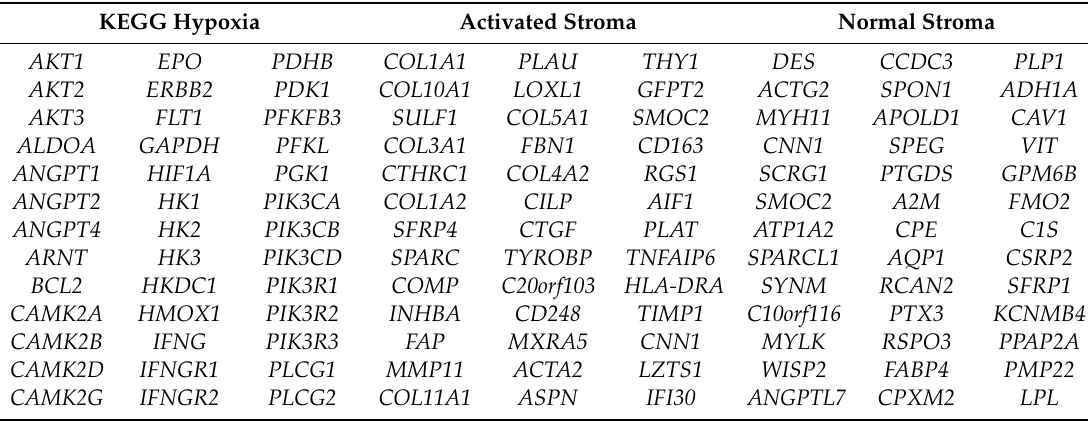
Table A3. Genes of KEGG hypoxia pathway, activated stroma and normal